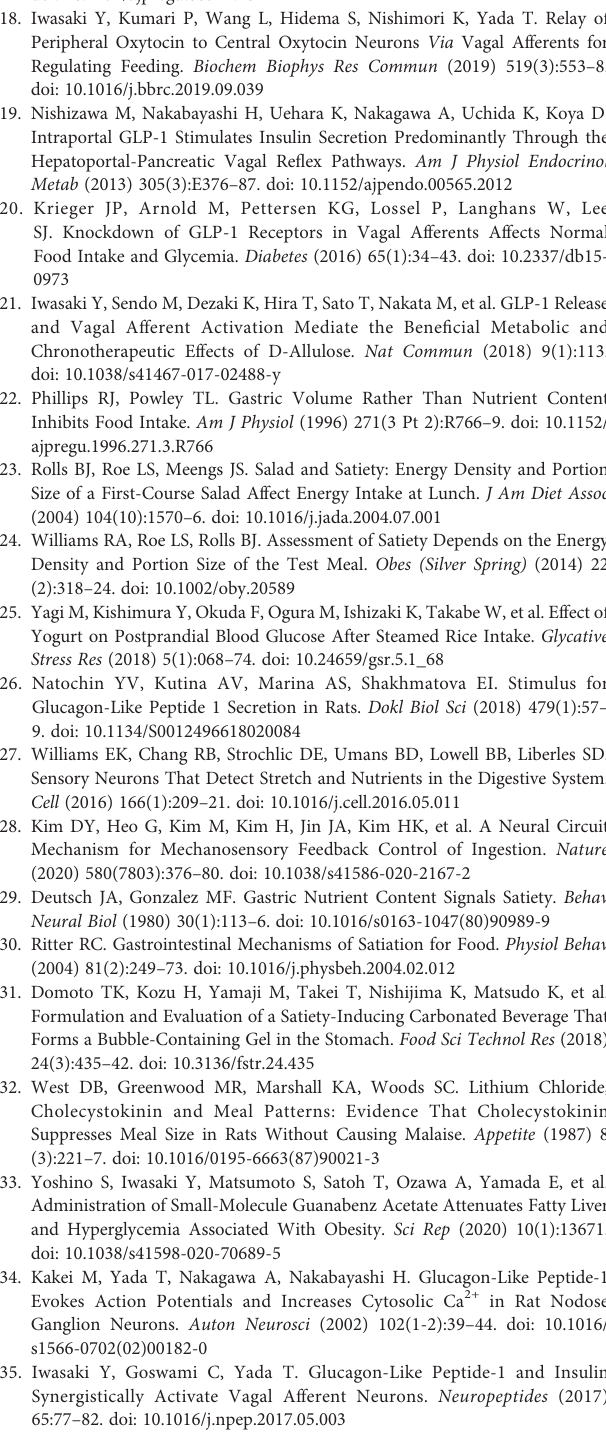
Supplementary Figure 2 | Expression of lipid metabolism-related genes in white adipose tissue (WAT) and uncoupling protein-1 in brown adipose tissue (BAT) in DIO mice subchronically treated with ISF. (A – C) Messenger RNA expression levels of the genes involved in lipid metabolism ( A ; Ppar g ,